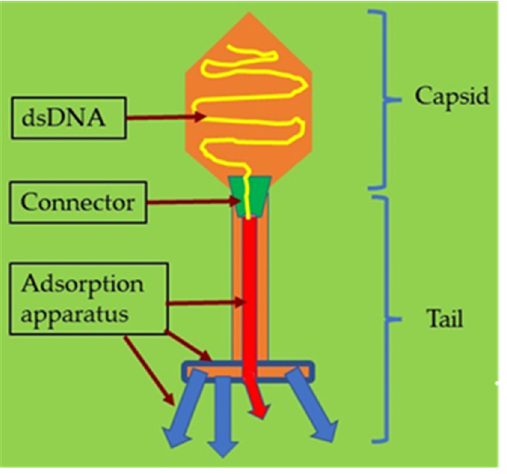
Figure 4. Illustration of a bacteriophage with its structure and